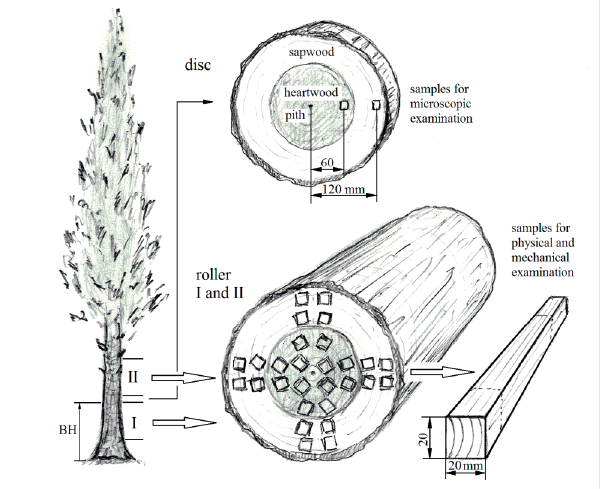
Figure 1. The method of preparing (cutting out) samples for individual